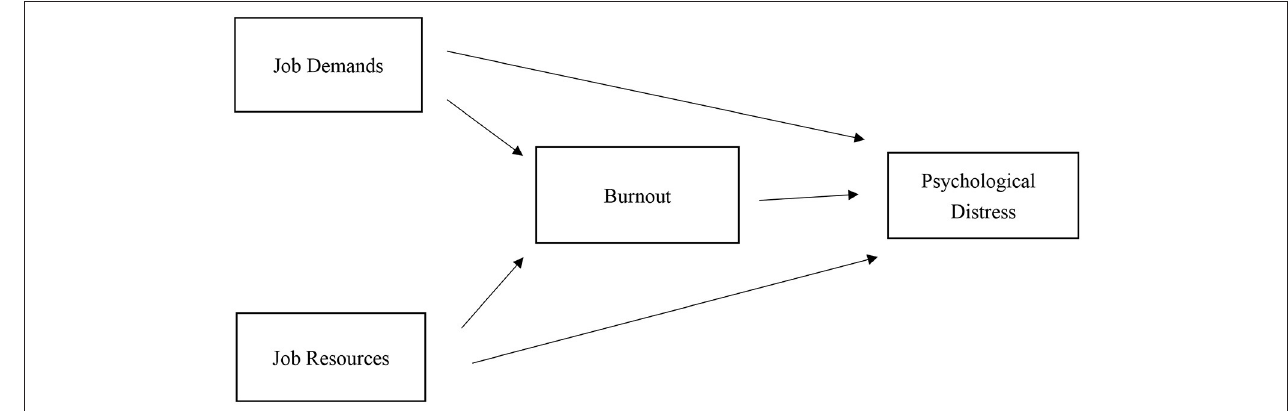
FIGURE 1 | Conceptual model of JD-R, burnout, and psychological